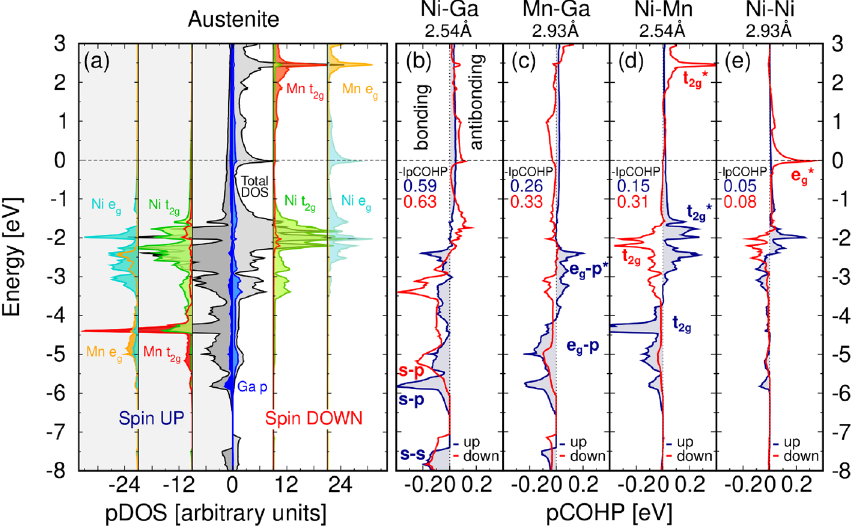
Figure 5. LOBSTER results of ( a ) pDOS projected on atoms, and ( b–e ) projected crystal orbital Hamilton population (pCOHP) calculated for atom pairs. The negative pCOHP represents stabilizing (bonding) while positive pCOHP represent destabilizing (antibonding) interactions, latter denoted by asterisk. The integrated values of IpCOHP/bond represent bond